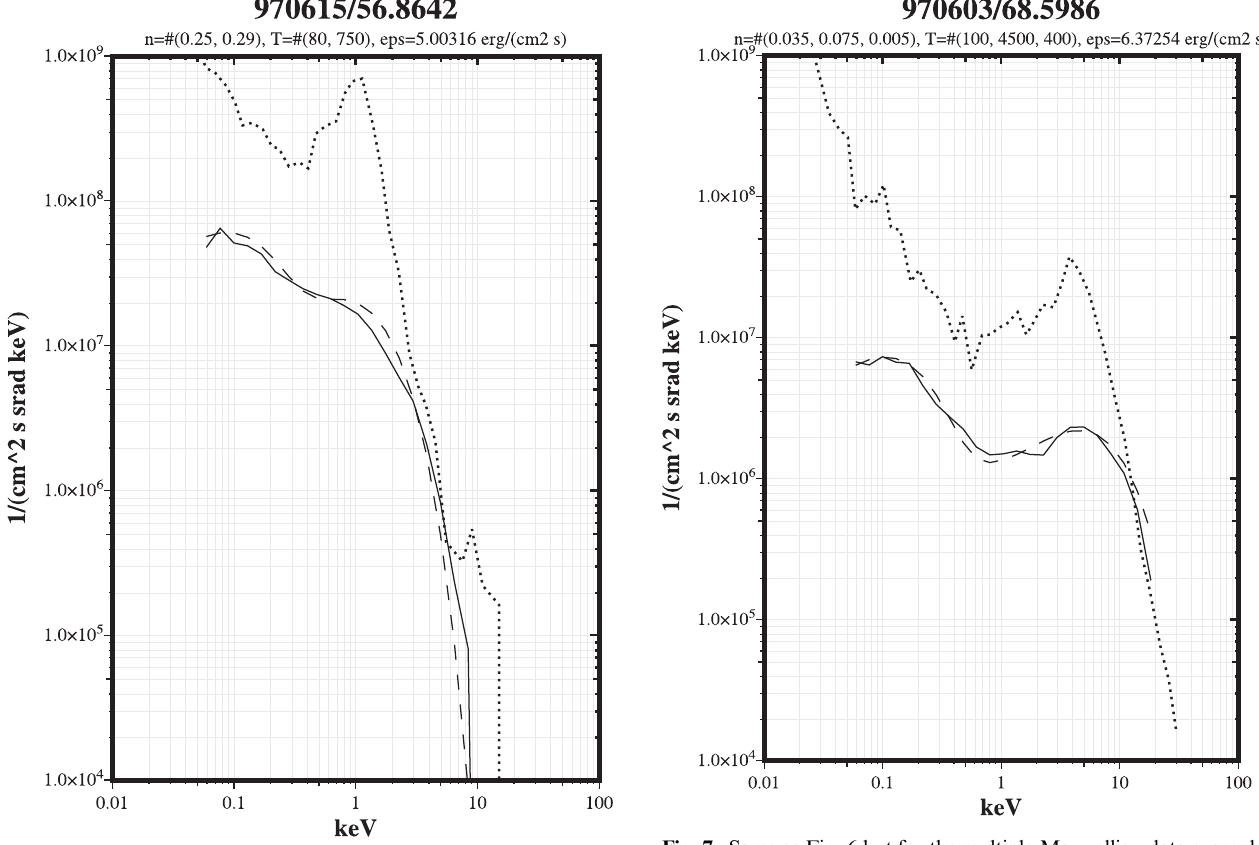
Fig. 7. Same as Fig. 6 but for the multiple-Maxwellian data example. The dashed line is the result of summing up three Maxwellian populations with densities 0.035, 0.075 and 0 : 005cm (cid:255) 3 and temper- atures 100, 4500 and 400